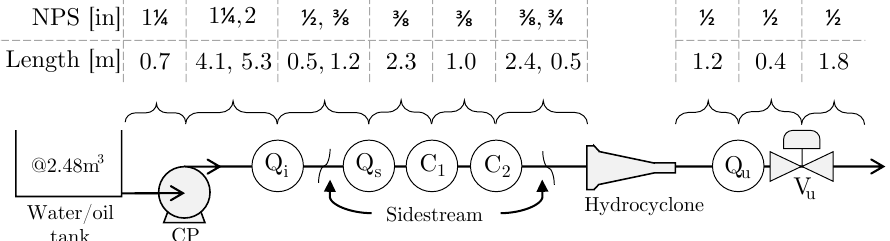
Figure 6. Illustration and table of the flow path with nominal diameter and length of pipes between instruments going through the